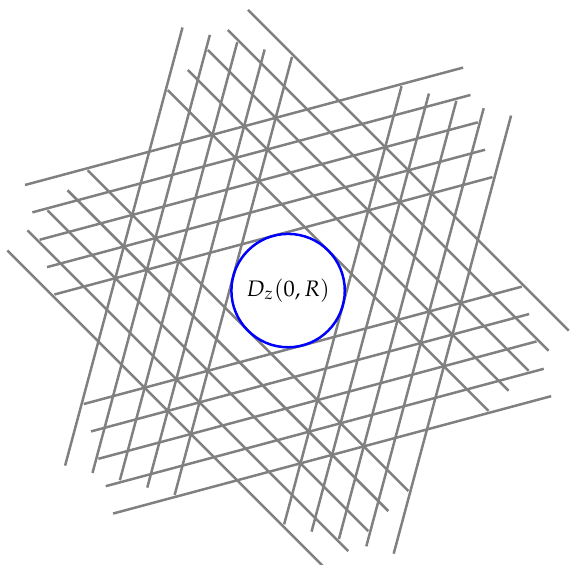
Figure 2. H ORIZONTAL CROSS - SECTION OF THE FFD-PAT SETUP .. Full field projections are measured over lines that do not intersect the ball B ( 0, R ) . Consequently, for any plane R 2 × { z } , integrals of p ( · , T ) over those lines are given that do not intersect the disc D z ( 0, R ) : = B ( 0, R ) ∩ ( R 2 × { z } ) . For planes with | z | ≤ R , this yields the exterior problem for the Radon